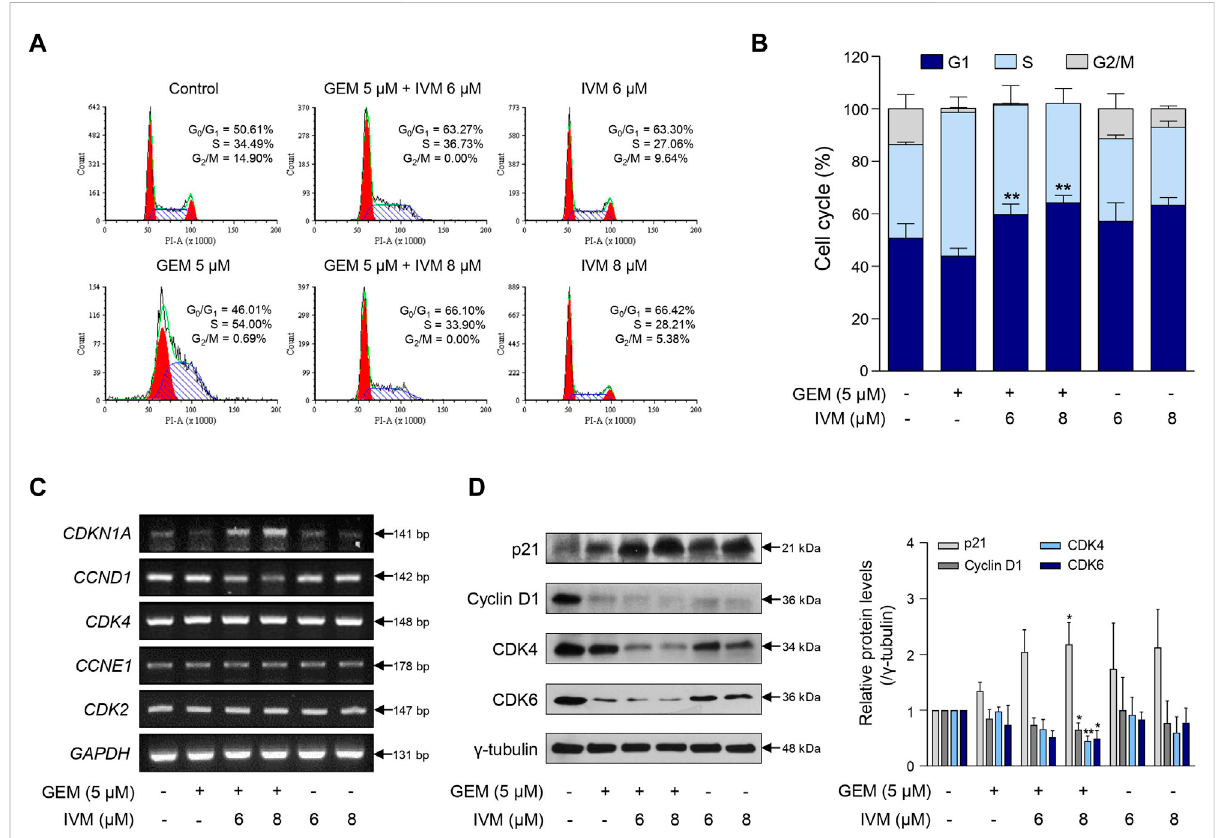
FIGURE 2 Ivermectin – gemcitabine combination induces G1 phase arrest. (A) MIA PaCa-2 cells were treated with the indicated concentrations of gemcitabine and ivermectin for 48 handmonitoredbypropidiumiodide (PI) staining and fl owcytometry. (B) Graph showingthepercentageof cells ateachstageofthecellcycle.Datarepresentsthemean±SD( n =3).* p < 0.05and** p < 0.01 comparedwiththegemcitabinealonegroup. (C) After the treatment of MIA PaCa-2 cells with gemcitabine and ivermectin, the mRNA expression levels of p21, cyclin D1, cyclin-dependent kinase (CDK)-4, cyclin E1, and CDK2 were estimated via polymerase chain reaction (PCR). (D) Protein levels of p21, cyclin D1, CDK4, and CDK6 were determined via western blotting of gemcitabine and ivermectin-treated cells. Data represents the mean ± SD ( n = 3). * p < 0.05 and ** p < 0.01 compared with the gemcitabine alone